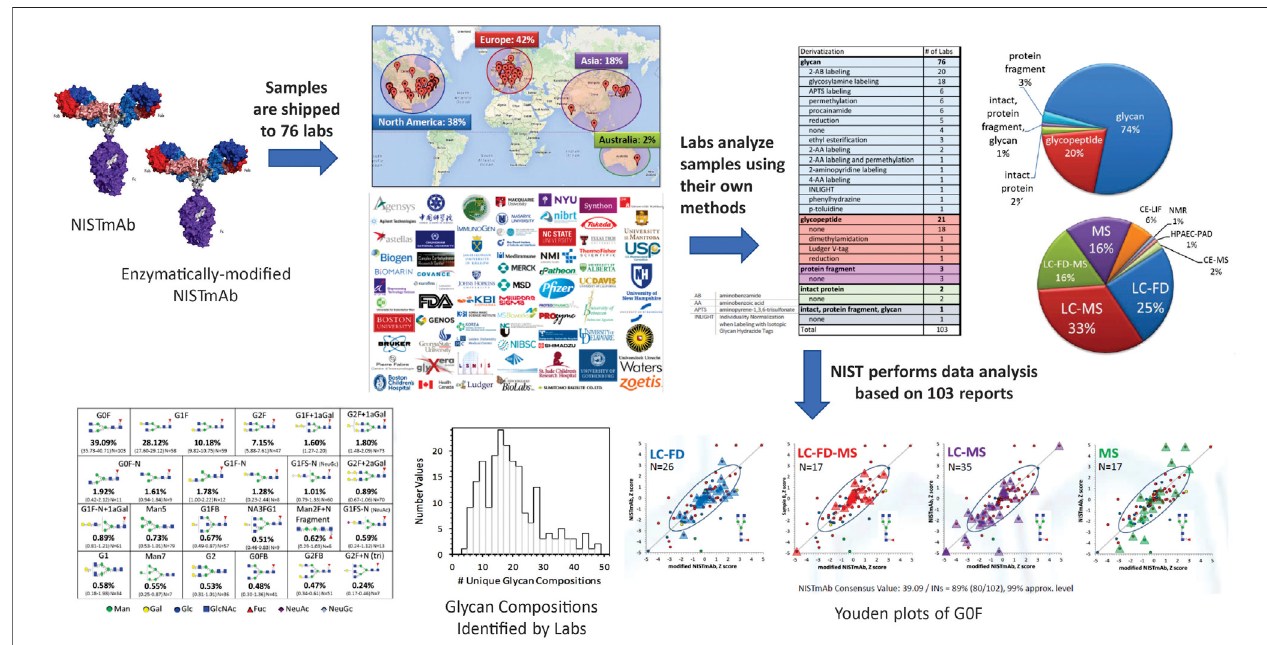
FIGURE 3 | Schematic description of the glycosylation interlaboratory study. Participating laboratories used the glycoanalytical and detection method(s) of their choice to determine relative abundance of